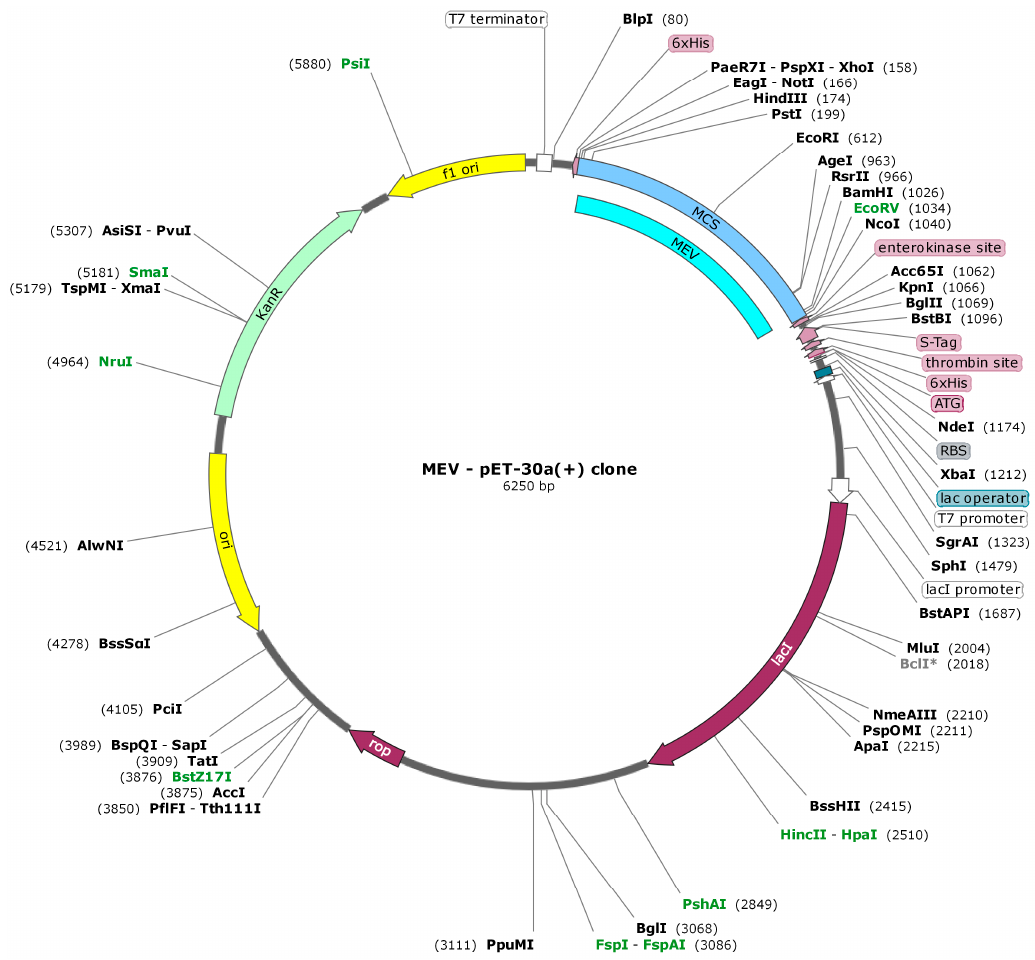
Figure 11. In silico cloning of codon optimized vaccine construct into E. coli K12 expression system. The inserted DNA sequence is shown in cyan color while keeping the plasmid back-bone in gray color.